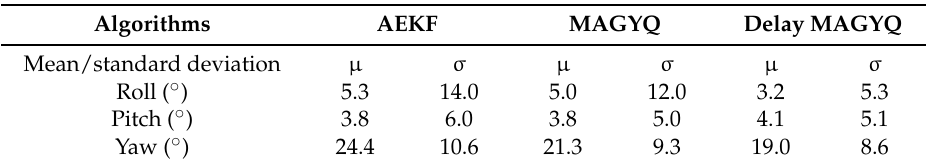
Table 2. Angular errors of AEKF, MAGYQ and Delay MAGYQ attitude estimation filters for the swinging scenario with all four